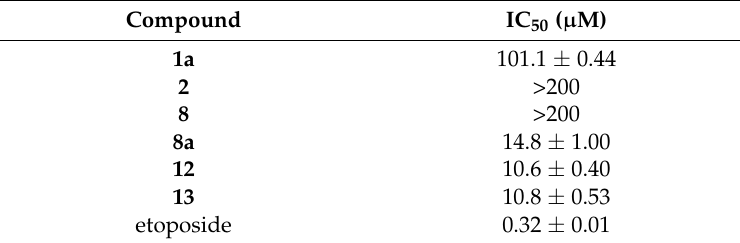
Table 2. Cytotoxic activity of 1a , 2 , 8 , 8a , 12 , 13 , and etoposide against HL-60 cells a .